Question: Sum up the contents of this chart in one sentence.
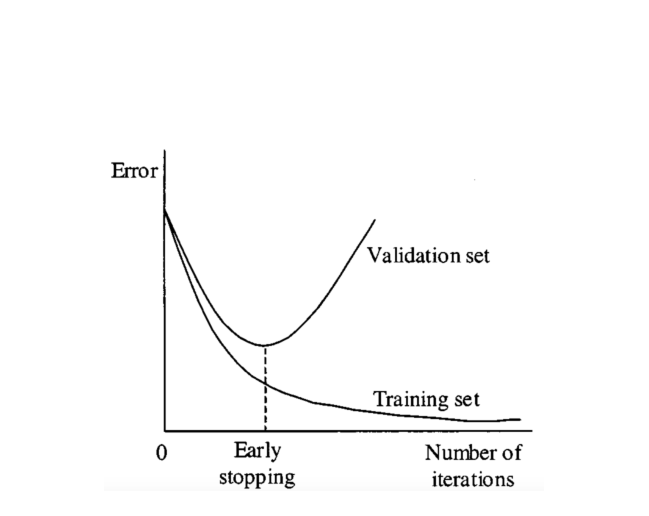
Answer: Visualization of early stopping mechanism. After the model converges, the early stopping mechanism halts the training process to prevent overfitting. Courtesy of Ramazan Genc¸ay.